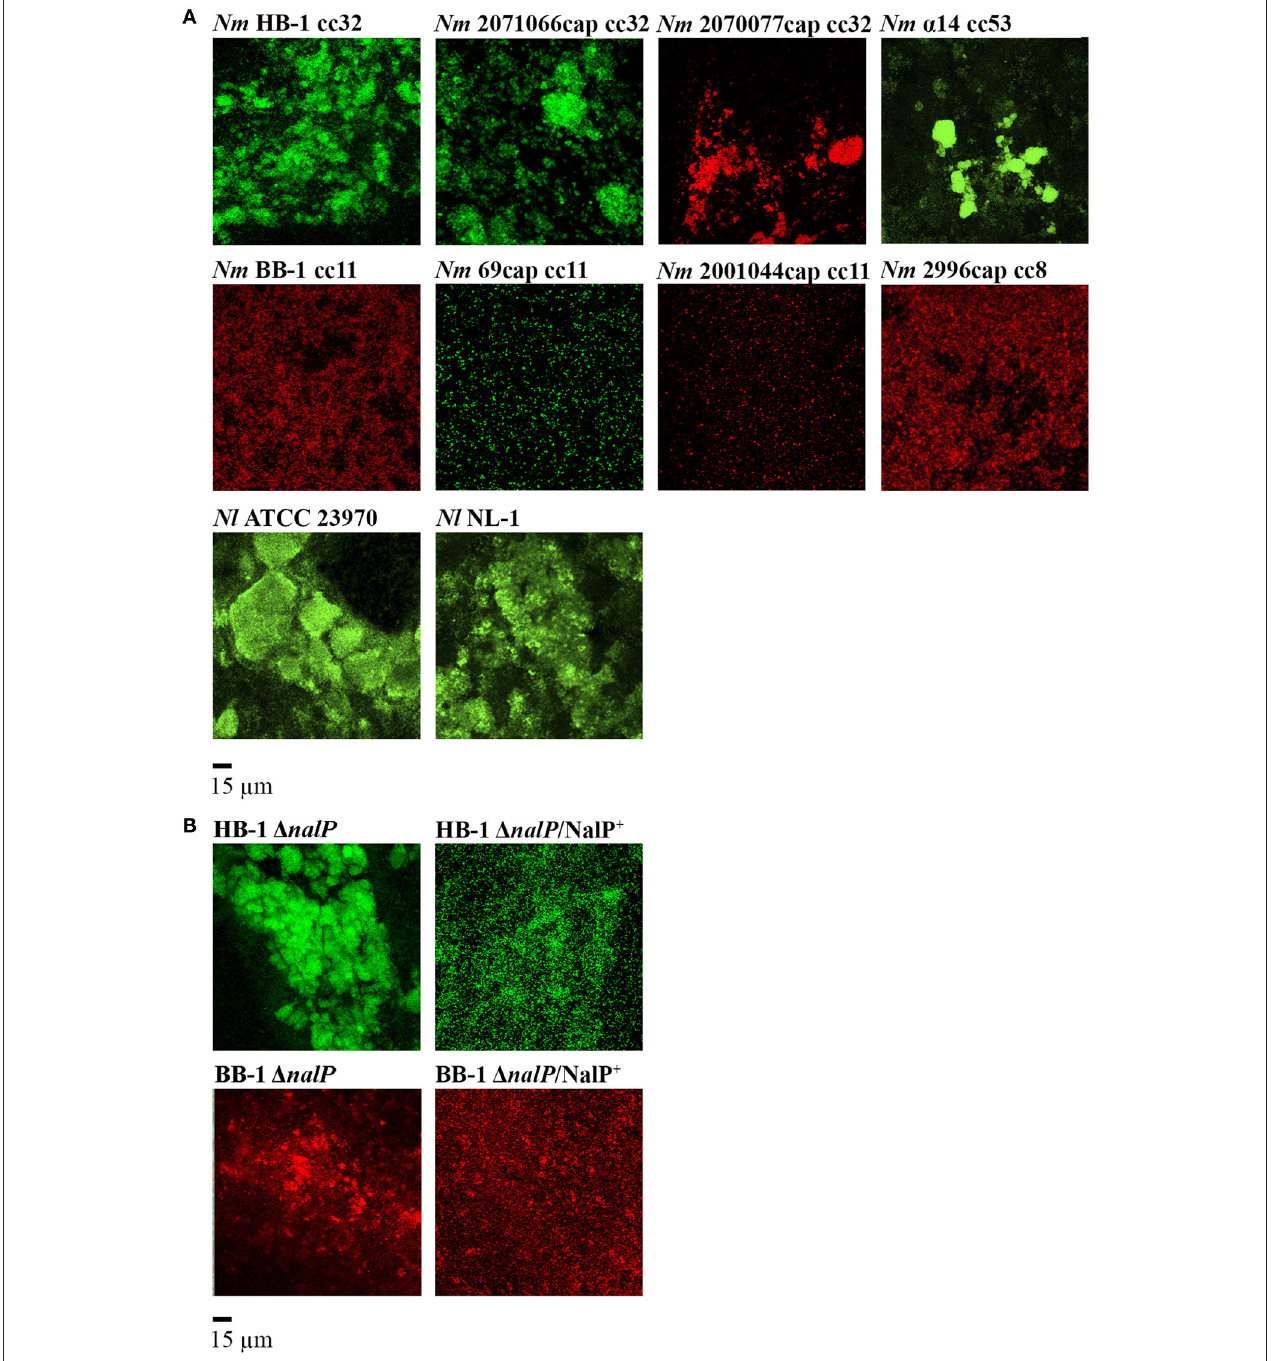
FIGURE 1 | Biofilm organization in various fluorescent Neisseria strains. (A) Biofilms of various strains of Nm and Nl. The clonal complex (cc) of the Nm strains is indicated. (B) Influence of nalP inactivation on biofilm architecture. Wild-type phenotypes are shown in (A) . HB-1 1 nalP/ NalP + and BB-1 1 nalP/ NalP + represent nalP mutants overexpressing NalP from plasmid pEN300. All strains harbor an opaB P H -gfp or opaB P H -rfp inserted into hrtA locus. Representative pictures from at least four experiments with two technical replicates are shown.